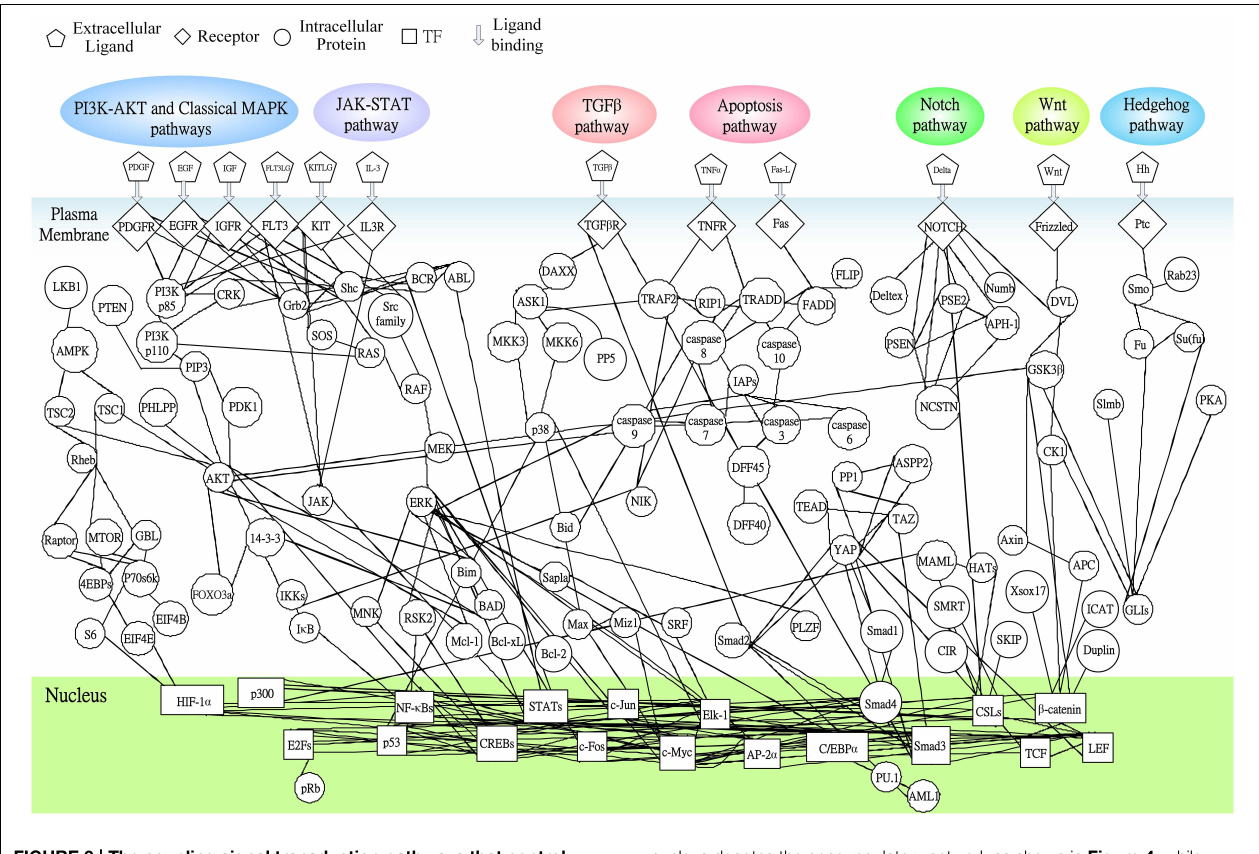
nucleus denotes the gene regulatory network as shown in Figure 4 , while the pathways in plasma denote protein-protein interactions. Other notations are defined and shown at the top of this